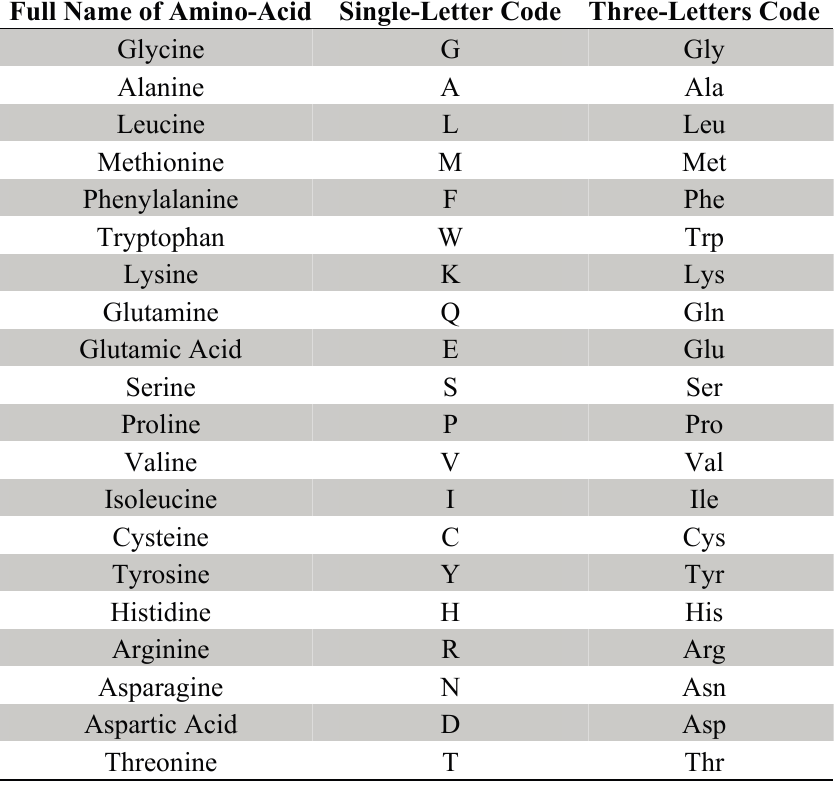
Table 1. Single-letter amino-acid code, In accordance to the international genetic system. Full Name of Amino-Acid Single-Letter Code Three-Letters Code